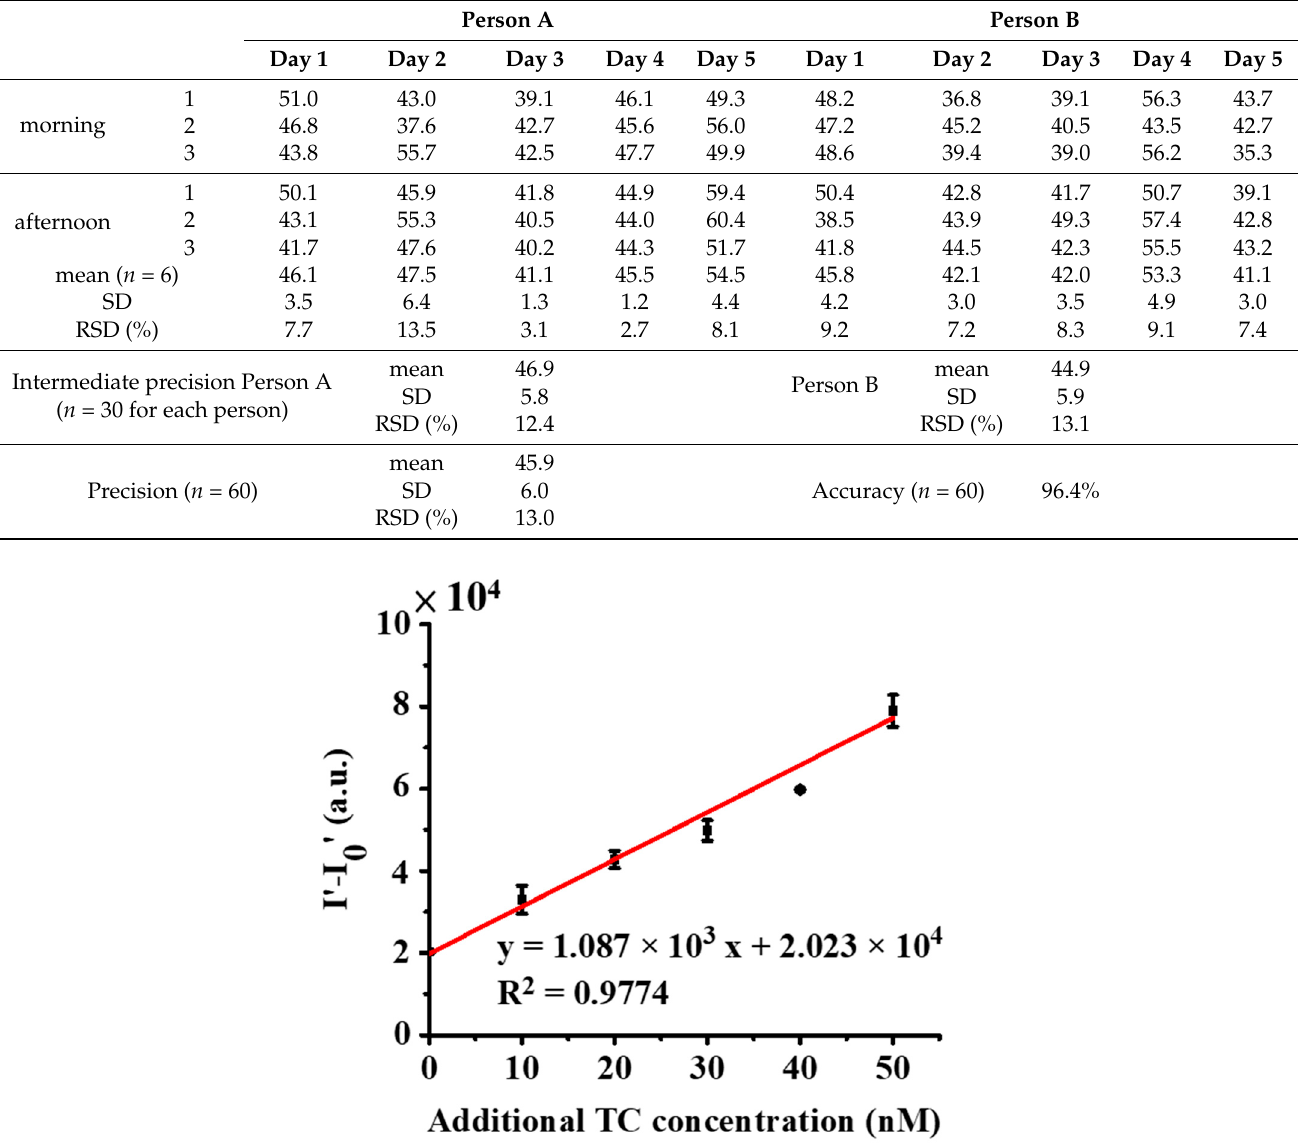
Figure 7. Quantitative analysis of TC (20 nM) spiked in a chicken broth sample obtained from the standard addition method. Calibration curve obtained from three replicates (Figure S5A–C) by plotting the difference of the fluorescence intensity of the samples containing Zn 2+ with (I ′ ) and without (I 0 ′ ) adding TC versus the concentration of TC. I ′ and I 0 ′ were individually obtained from their differences of the corresponding fluorescence intensity at the wavelength of 500 nm to 750 nm in the resultant fluorescence spectra.